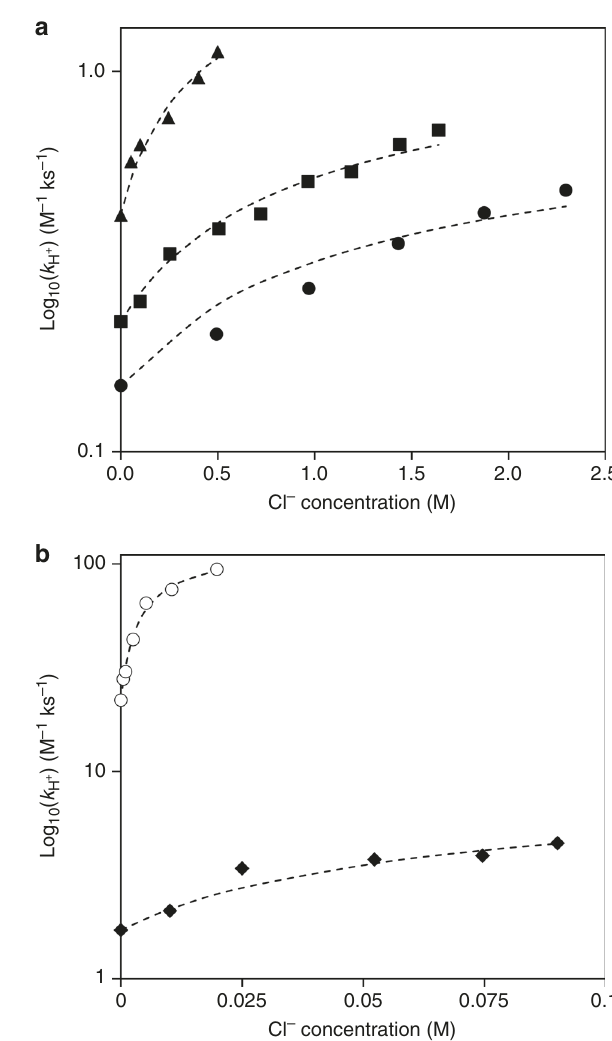
Fig. 2 Fructose conversion rate constant versus Cl − concentration in GVL/ H 2 O (w/w). a Overall, 5% GVL (black circles), 25% GVL (squares), and 50% GVL (triangles). b In all, 75% GVL (diamonds) and 90% GVL (hollow circles). Black dashed lines represent the model fi ts using Equation (7). Reaction conditions: fructose (50 mM); acid (H 2 SO 4 ; 5 mM – 0.5 M); salt (KCl; 5 mM – 2.5 M), 373 K; solvent (5 mL); stirring (700 rpm). Reaction rate constant values: r = k H + [R] [H + ]